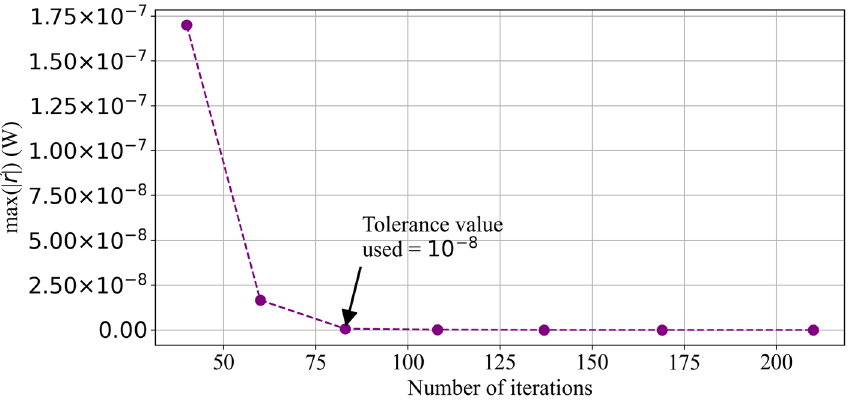
Figure 4. Convergence analysis.